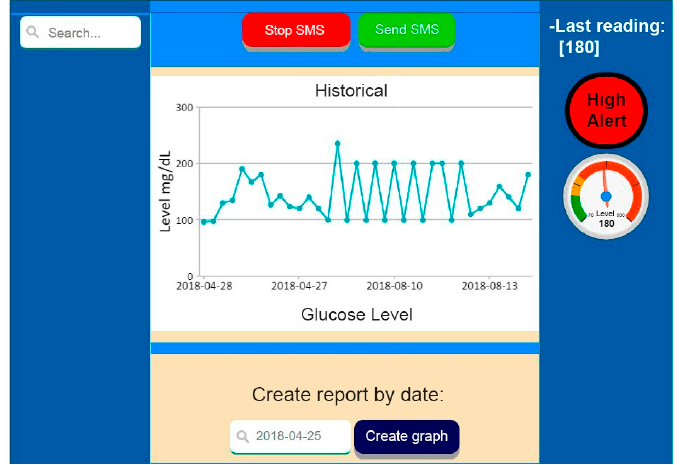
Figure 6. Glucose level prognosticated using the double moving average, showing a critical condition.